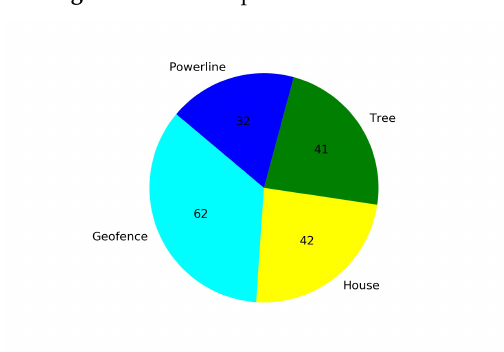
Figure 34. Crash report chart for Case 2.1.